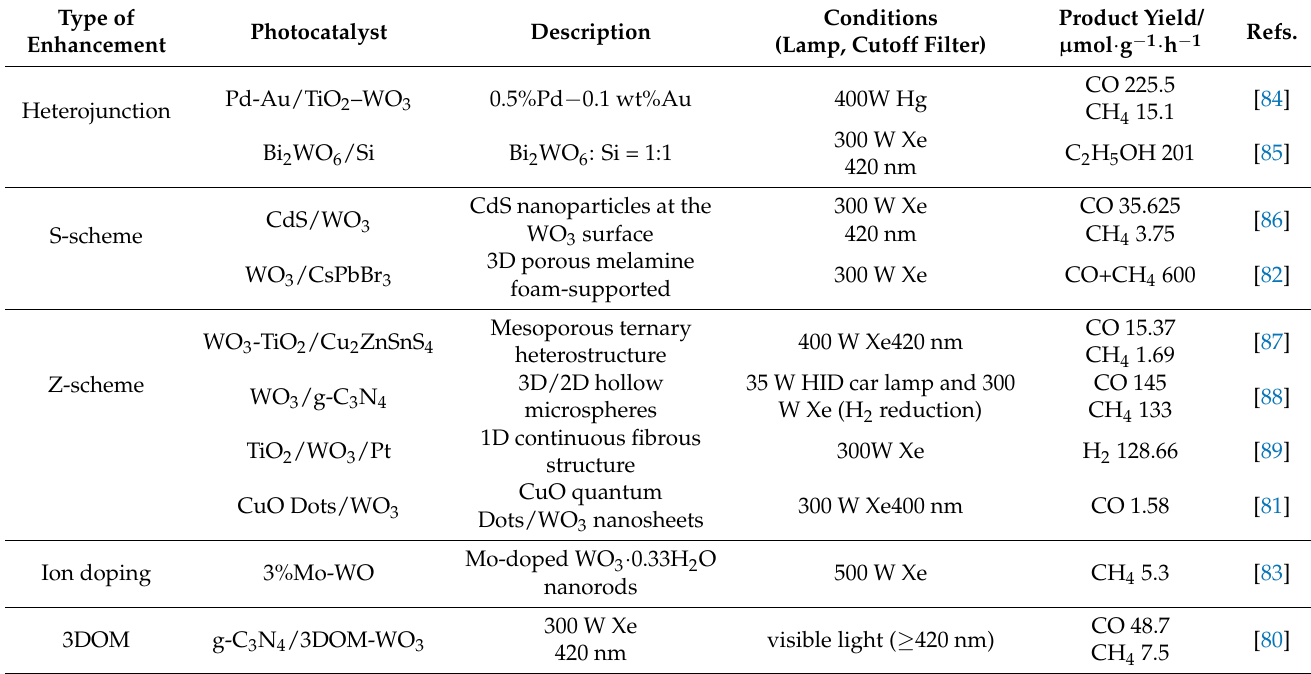
Table 2. Summary of the recent results on the photoreduction of CO 2 by WO 3 -based